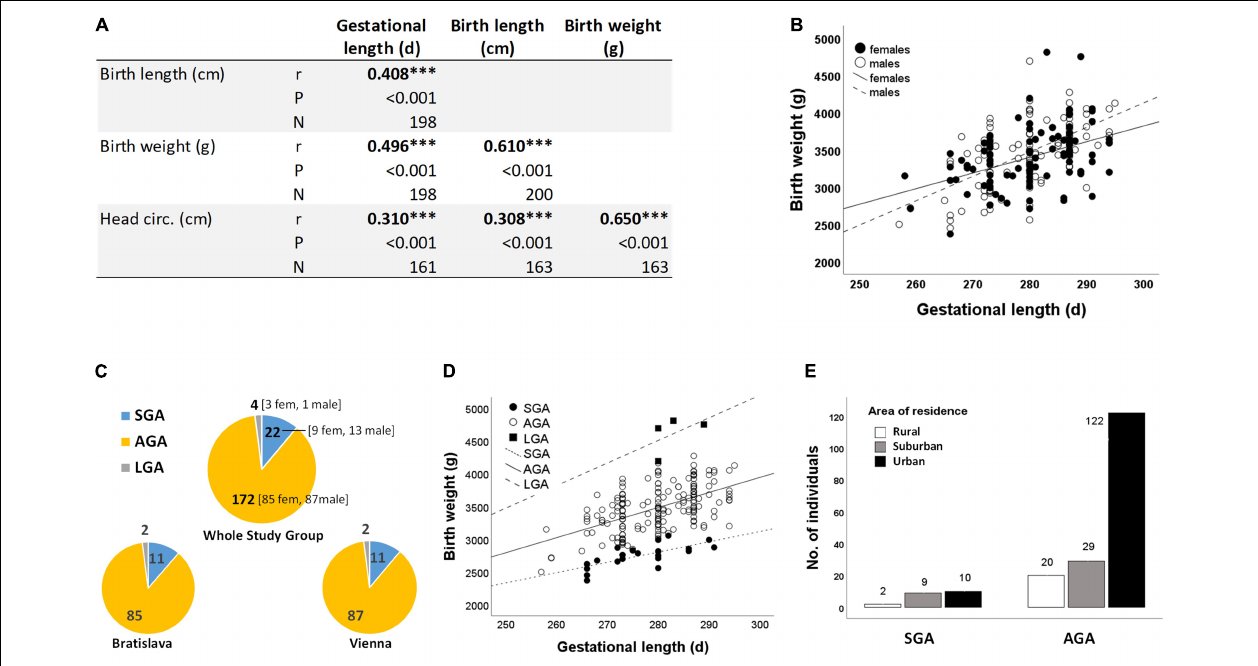
FIGURE 4 | (A) Correlations between neonatal anthropometry and gestational length *** P < 0.001 (Spearman correlation) (B) as exemplified for birth weight and gestational length in subgroups of girls ( r = 0.583, N = 97) and boys ( r = 0.417, N = 103). (C) Birth outcome (i.e., SGA, AGA, and LGA) is almost the same at both study sites (Chi-square test P = 0.998). (D) Birth weight increases with gestational length independent of birth outcome (SGA: r = 0.711, N = 22; AGA: r = 0.551, N = 172; LGA: r = 0.515, N = 4). (E) Relationship between residential area and birth outcome (Chi-Square test P = 0.019). Three study participants did not provide information on residential area ( Table 1 ), resulting in smaller numbers of SGA cases ( N = 21) and AGA cases ( N = 171) here.